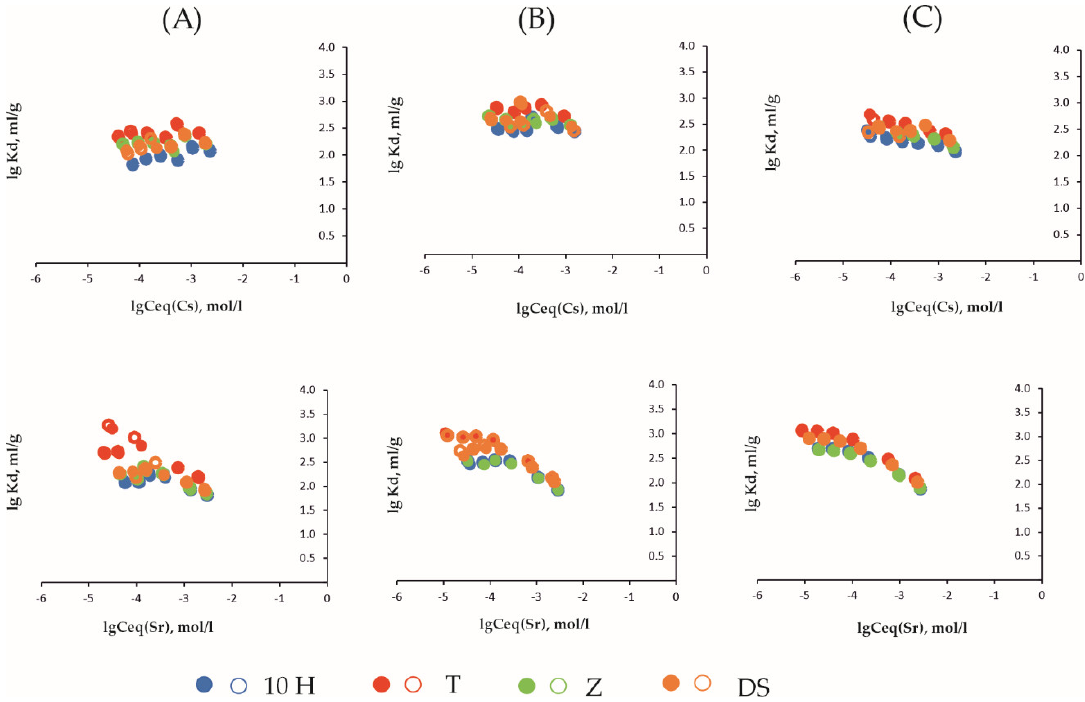
Figure 4. Dependence of lgKd on lgC eq in the experiments with bentonites 10H, T, Z, and DS at pH of the initial solution 3 ( A ), 7 ( B ), and 10 ( C ). Empty and filled icons are replications of the experiment.